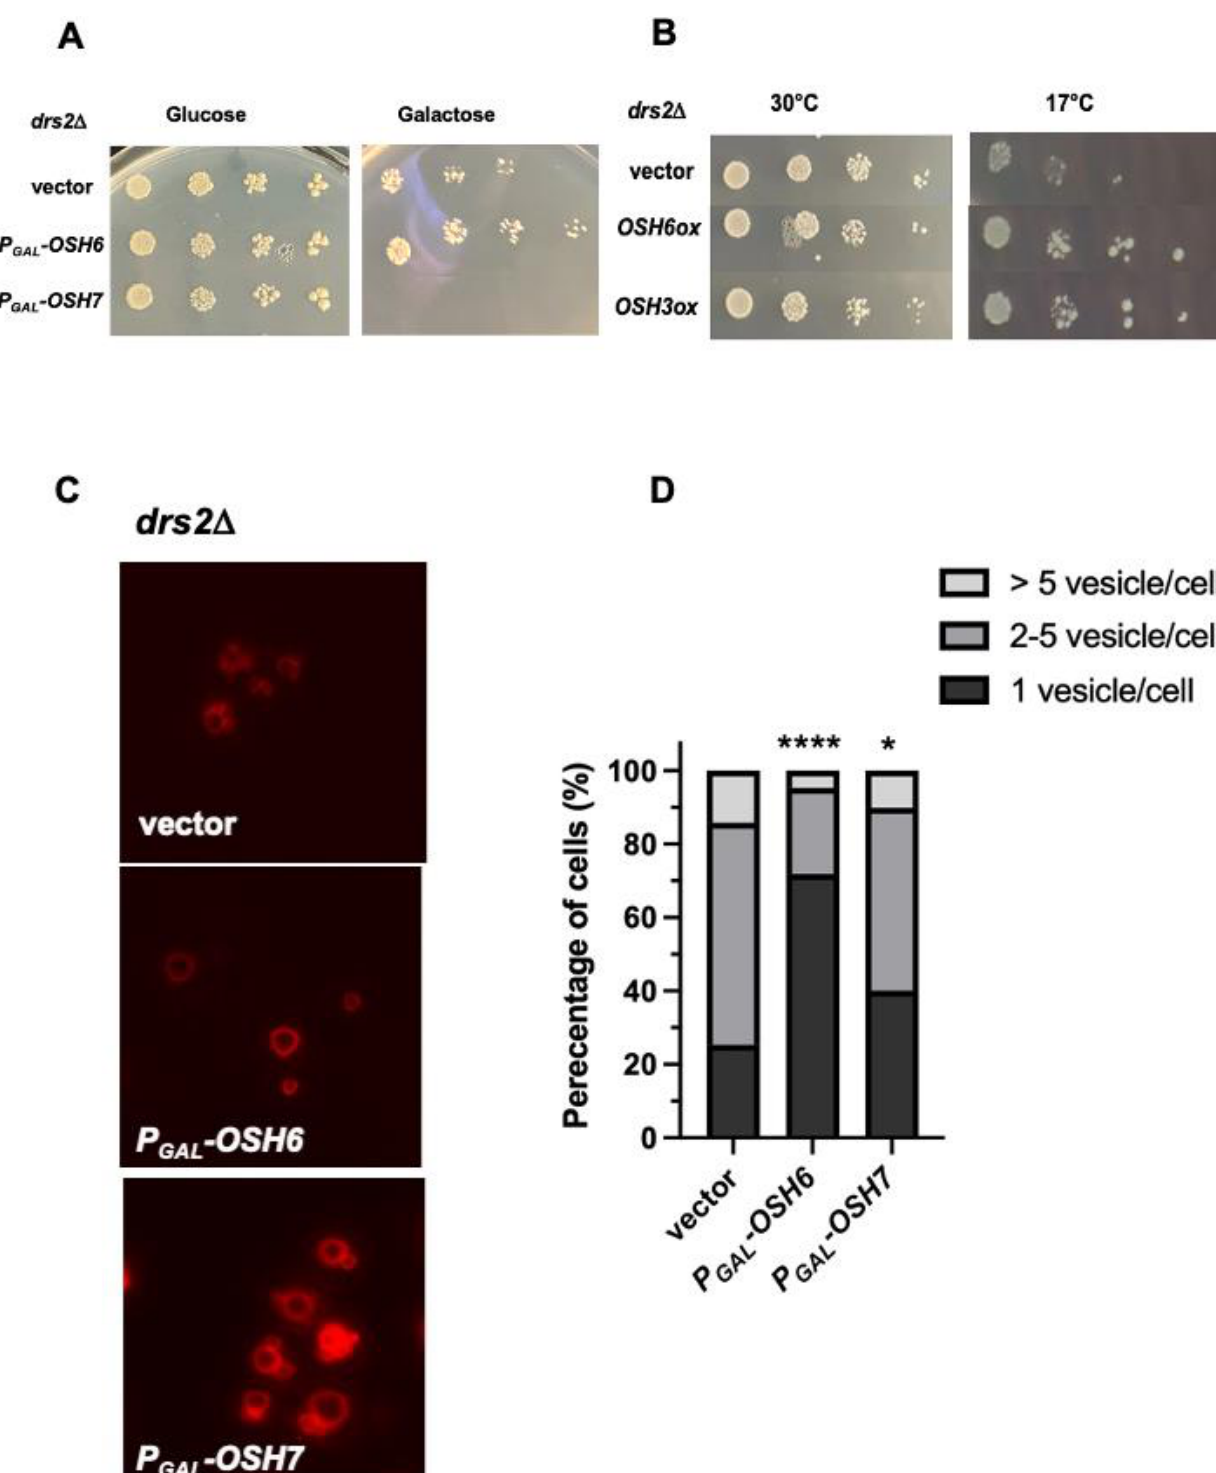
FIGURE 1: OSH6 genetically interacts with DRS2 . (A) Growth of drs2 ∆ cells with vector, P GAL - OSH6 (pCB248), or P GAL - OSH7 (pCB247) on SC-URA with glucose or galactose media at 30 ℃ for two days. (B) Growth of drs2 ∆ cells with vector, high copy OSH6 (pCB237), or high copy OSH3 (pCB238) on SC-URA at 30 ℃ for two days or 17 ℃ for ten days. For A and B, 5 µl of serially diluted cells (0.1 OD/ml for the left) were spotted on the plate and then incubated. (C) Vacuolar morphology of drs2 ∆ cells with vector or the indicated plasmid. Overnight cultures were labeled with FM4-64 for one hour and chased at 30 ℃ for three hours and then photographed. (D) Quantitative analyses of vacuolar morphology from Fig. 1C. Cells were divided into three categories based on the number of vacuolar vesicles/cell. Sample sizes are 138 for drs2 ∆ (vector), 180 for drs2 ∆ (Pgal-P GAL - OSH6 ) and 194 for drs2 ∆ (P GAL - OSH7 ). A one-way ANOVA analysis shows that the fraction of cells with one vesicle/cell of P GAL - OSH6 is significantly different from that of vector (p<0.0001). Differences between P GAL - OSH7 and wild type is also significant